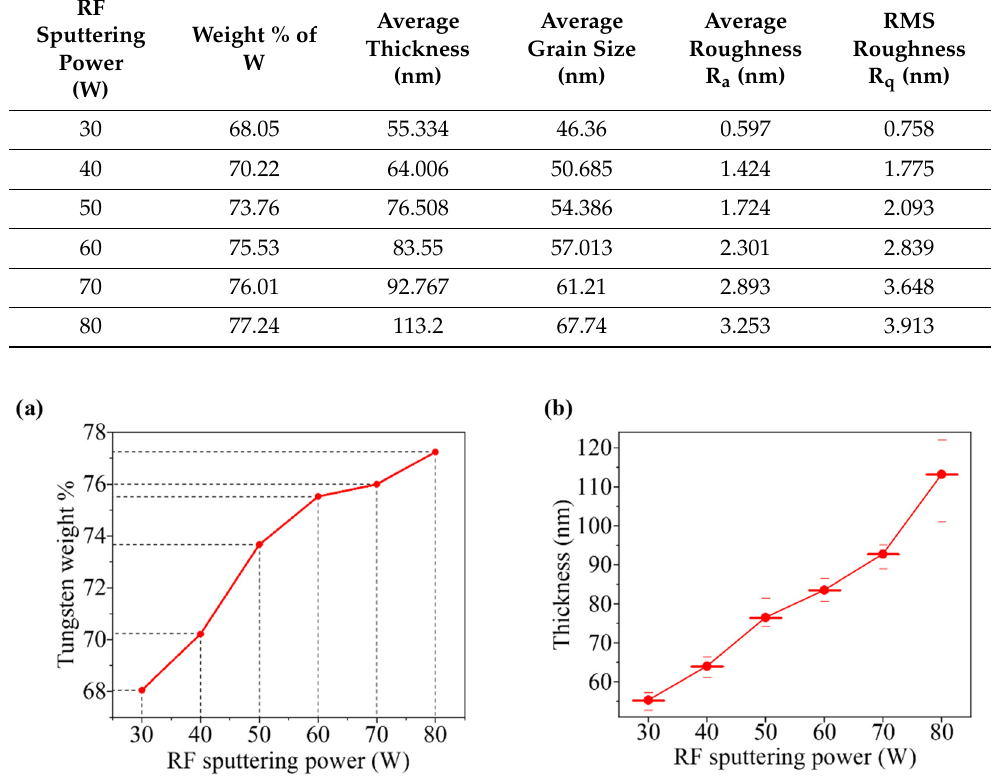
Figure 1. Variation of: ( a ) weight % of W and ( b ) thickness due to the RF sputtering power.